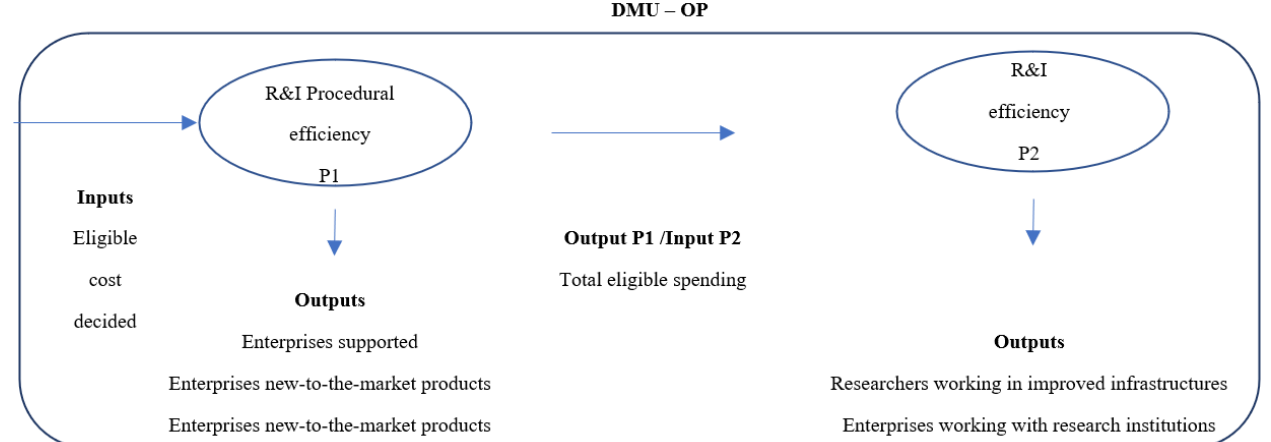
Figure 1. Network structure.